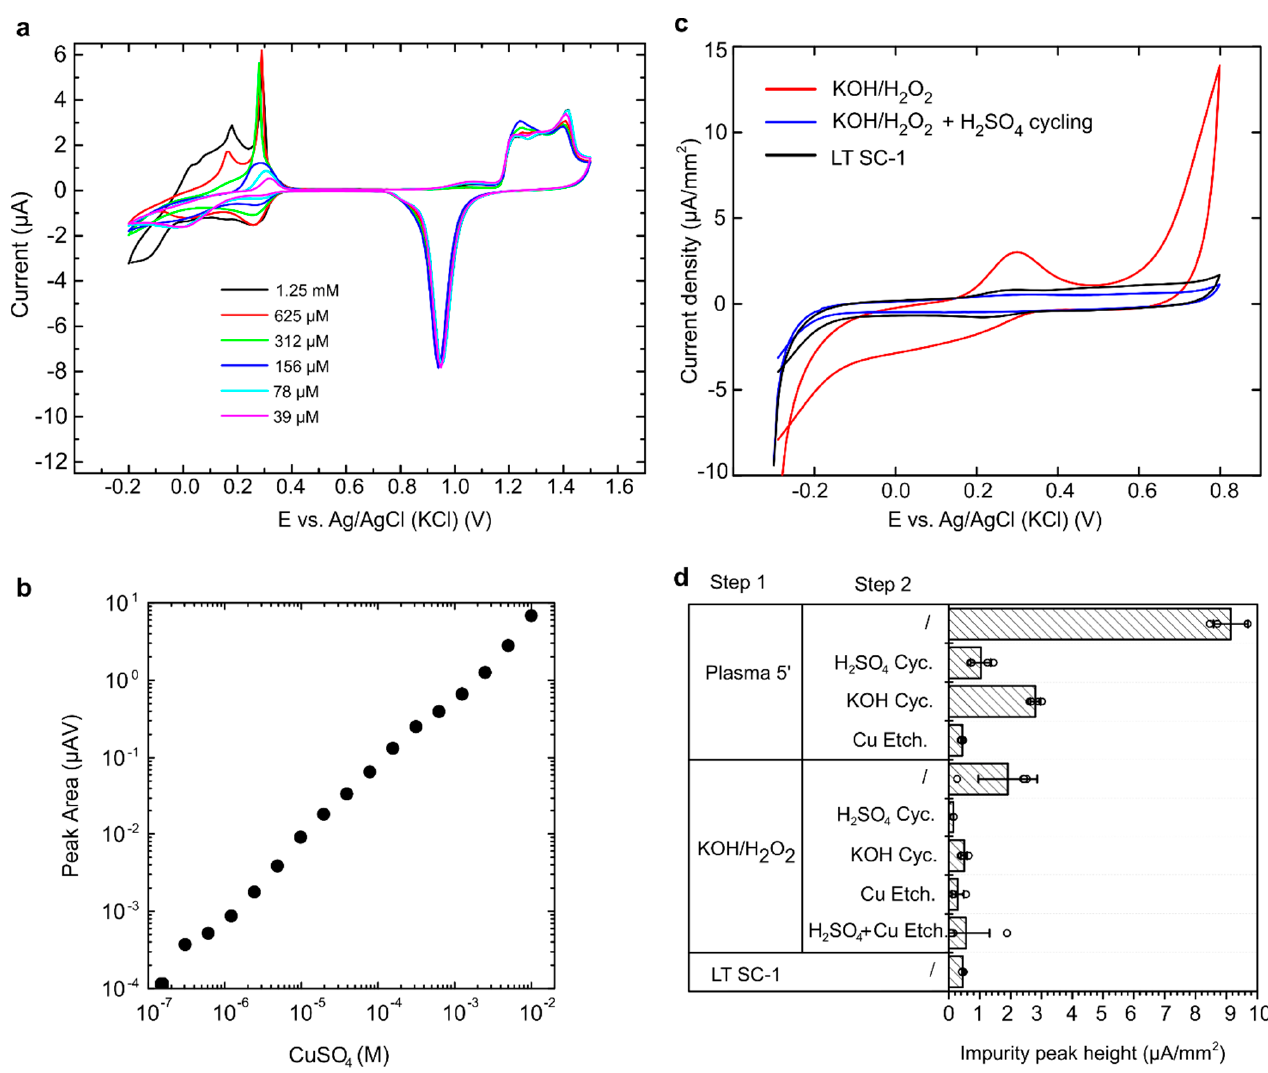
Figure 2. Determination of copper impurities in PCB electrodes. ( a ) CV curves obtained in sulphuric acid with increasing concentrations of CuSO 4 . ( b ) The relationship between CuSO 4 concentration and peak area obtained in CV scans. ( c ) Analyses by CV in PBS, where Cu impurity peak is revealed at approximately 0.3 V. ( d ) The height of impurity peaks in PCBs that underwent various combinations of cleaning procedures (step 1 plus step 2). Bars represent the mean, error bars represent the SD, and empty circles represent individual data points.